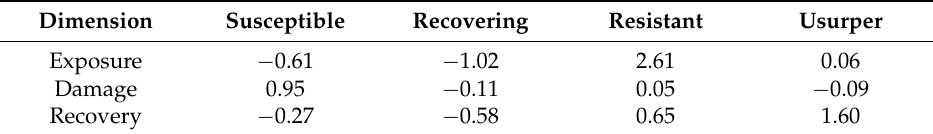
Table 2. Z-scores of centroids of the four resilience types on the three dimensions. Dimension Susceptible